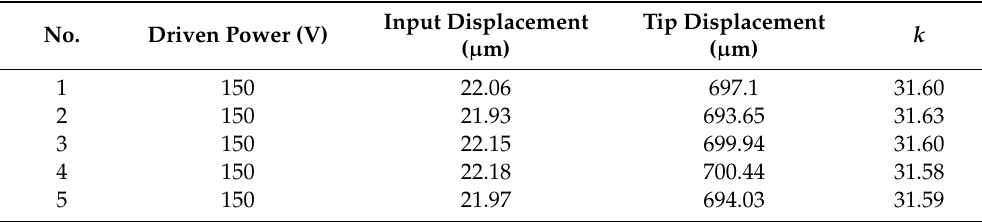
Table 2. Experiment results of displacement